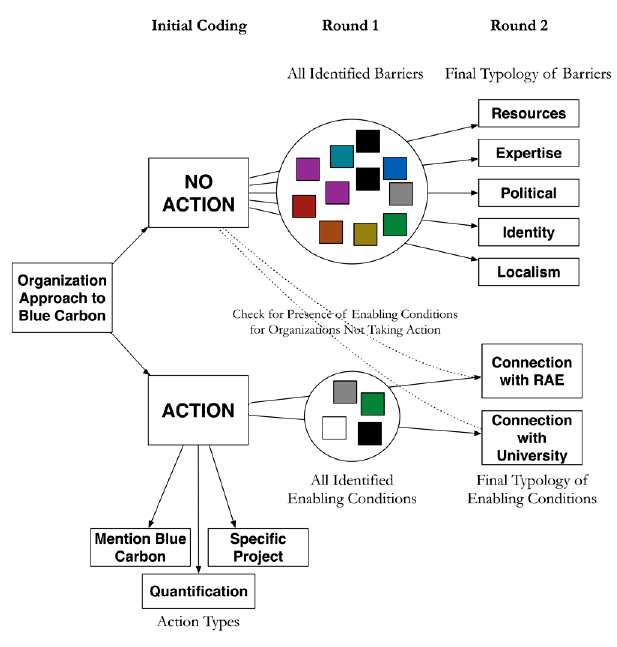
Fig. 2 . Coding tree for interview transcript